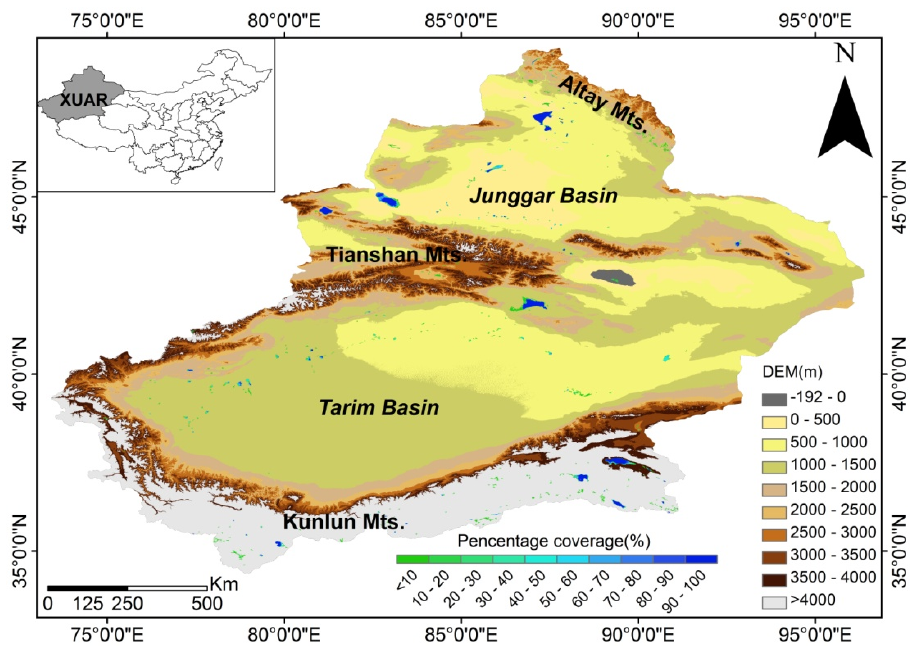
Figure 1. Geographic location and topographic map of study area. The percentage coverage of water bodies was combined for April, July, and September from 2000 to